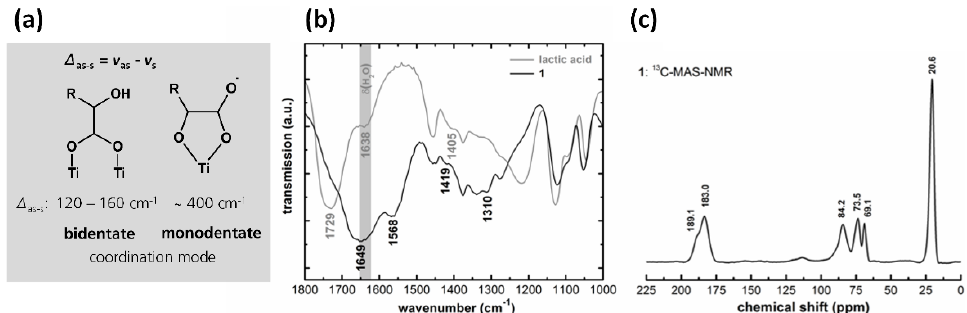
Figure 2. Differences ( Δ as-s ) in the asymmetric ν as (COO − ) and the symmetric ν s (COO − ) stretching mode of lactate chelated to Ti. Values of 120–160 cm − 1 indicate a bidentate coordination of lactate; values >400 cm − 1 indicate a monodentate coordination mode ( a ). The FTIR spectra of lactic acid (grey line) and 1 (black line). ν as (COO − ) and ν s (COO − ) are marked in the spectra indicating a monodentate as well as a bidentate coordination mode of lactate to Ti ( b ). The 13 C-MAS-NMR spectrum of 1 indicating two different coordination modes of lactate to Ti ( c ).